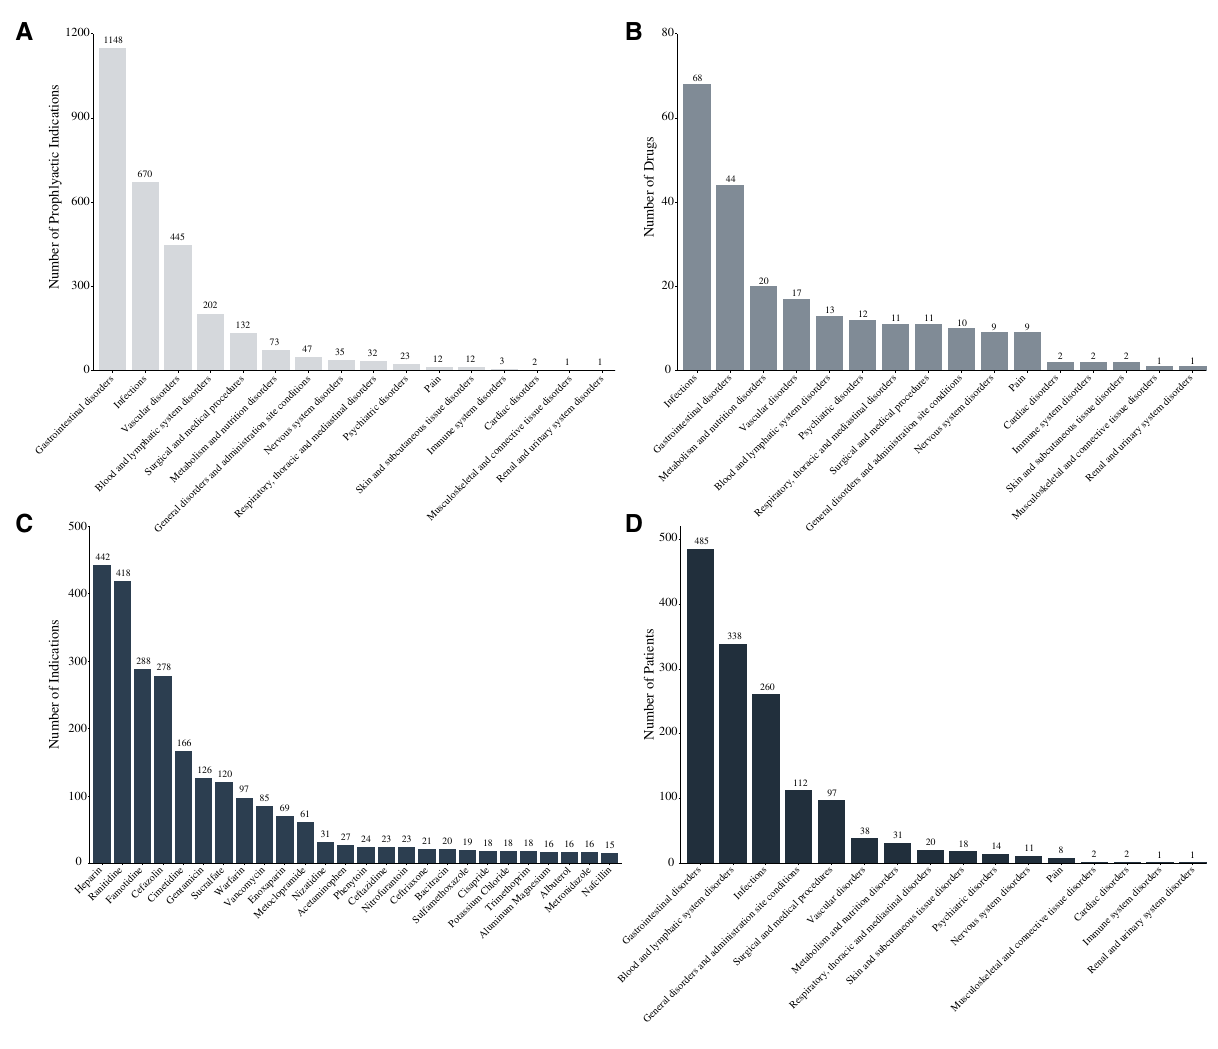
Figure 4. Prophylactic pharmacological treatment to prevent secondary complications from occurring. ( A ) Number of indications per organ system. The majority of prophylactic indications were related to the gastrointestinal and vascular system as well as infections of all sorts. ( B ) Number of unique medications administered to for disease prophylaxis. ( C ) Number of indications per medications. Anticoagulants, antihistamines, and antibiotics were amongst the most frequently administered medication classes. ( D ) Number of patients that received prophylactic treatment per organ system. The majority of the patients enrolled in the Sygen trial (n = 666 [83.6%]) received at least one medication for disease prophylaxis. The average number of medications per patient was 3 (range 1–21) and average number of indications per patient was 4.3